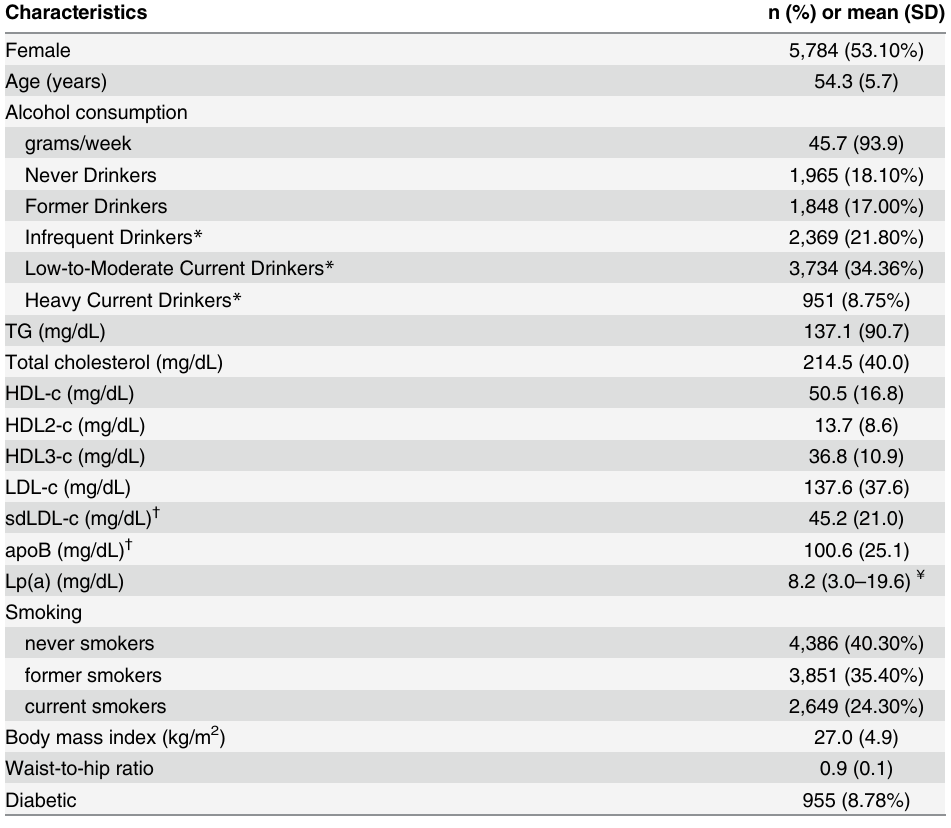
Table 1. Characteristics of 10,893 ARIC EAs.